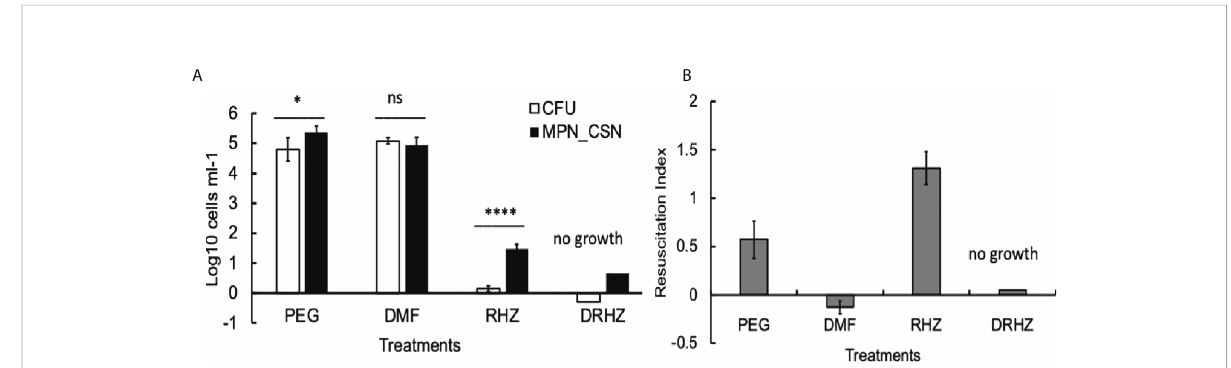
FIGURE 3 Effect of dimethyl fumarate (DMF), standard treatment and standard treatment with DMF on Mtb loads in the infected spleens after 8 weeks of treatment. (A) Spleen homogenates were used for CFU and MPN_CSN assays. Data shown as means ± STDV ( N = 5) (B) . The resuscitation indices were calculated using the following formula: RI= log 10 (MPN_CSN ml -1 ) – log 10 (CFU ml -1 ). Ns, non-signi fi cant; p > 0.05; * p < 0.05; **** p < 0.0001 unpaired t -test. No Mtb were recovered in the DHZR group; the presented bars indicate the limit of detection for the MPN assay 4.6 cell ml -1 and 0.25 cell ml -1 (CFU). PEG, control PEG 400 group; DMF, dimethyl fumarate group; RHZ, rifampicin, isoniazid and pyrazinamide group; and DRHZ, rifampicin, isoniazid, pyrazinamide and dimethyl fumarate